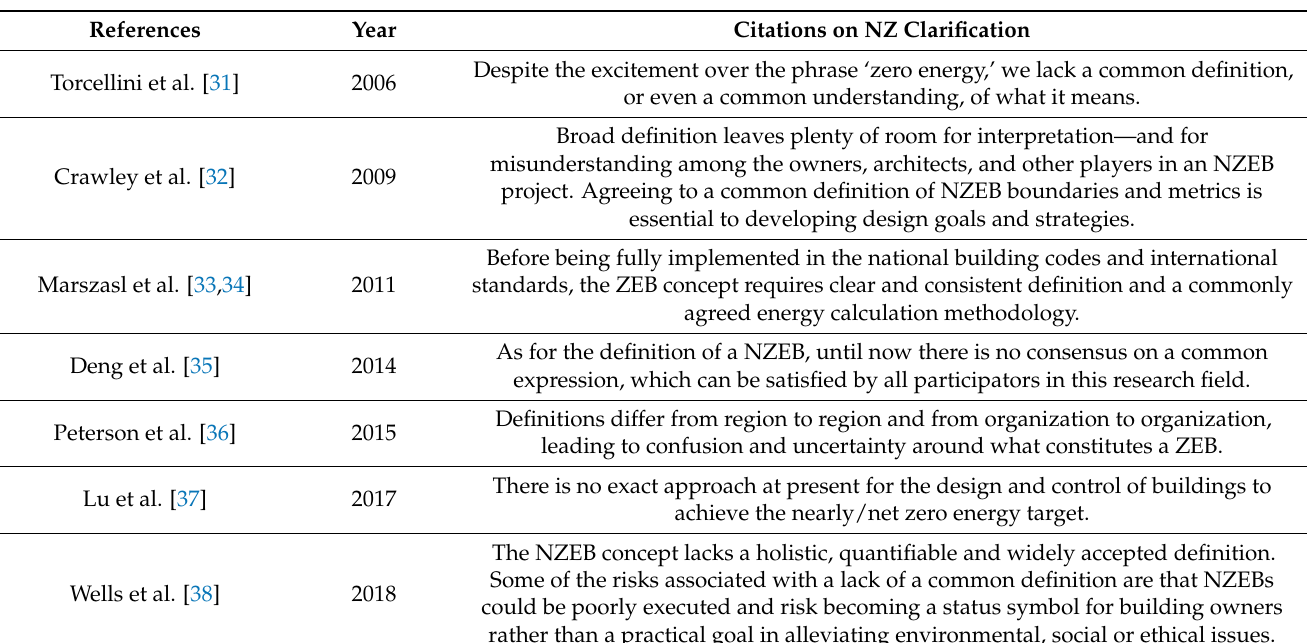
Table 1. Limitations in NZ